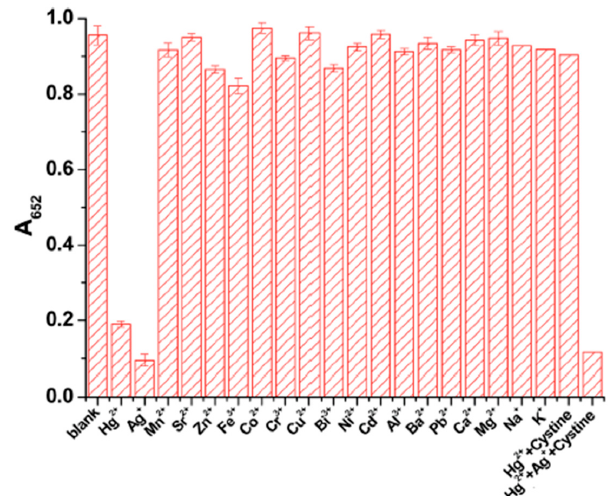
Figure 12. Selectivity of Au@Pt nanoparticles towards various metal ions in the presence of sodium dodecyl sulfate. (Reprinted with permission from [126]. Copyright © 2017, Royal Society of Chemistry).